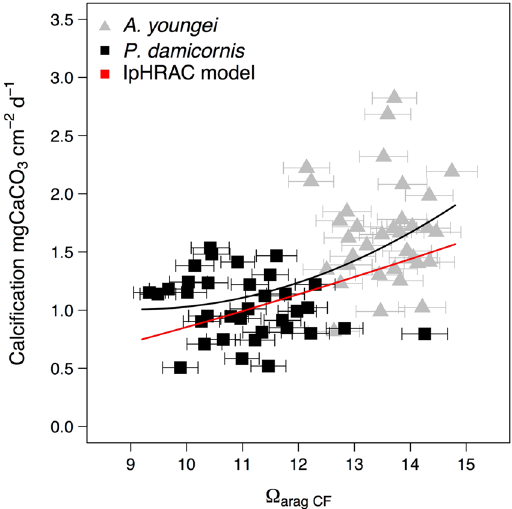
Figure 4. Calcification rates of Acropora youngei (grey triangles) and Pocillopora damicornis (black dots) as a function of estimates of the aragonite saturation state in the calcifying fluid (Ω arag cf ) made using estimates of pH cf and DIC cf . The horizontal error-bars represent the uncertainties on Ω arag cf estimates. The mean relationship between calcification and Ω aragCF for both species was best fitted by the polynomial relationship y = 0.025 X 2 + 0.63 x + 3.03 (black line). The red lines corresponded to a “bio-inorganic model” of calcification based on the known abiotic rate kinetics of CaCO 3 precipitation as a function the aragonite saturation state Ω cf (IpHRAC) 9 . This model is based on an empirical exponential rate dependence law for carbonate